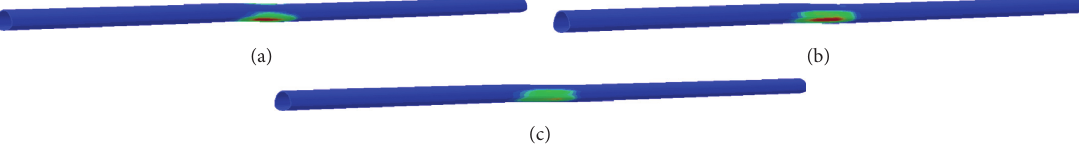
Figure 9: The cloud diagram development range of the plastic zone of the lining with different ratios of 1.4 m at the 45 ° dip angle. (a) The cloud diagram of plastic zone of 1.4m tunnel lining with a ratio of 1:1. (b) The cloud diagram of plastic zone of 1.4m tunnel lining with a ratio of 1: 2. (c) The cloud diagram of plastic zone of 1.4m tunnel lining with a ratio of